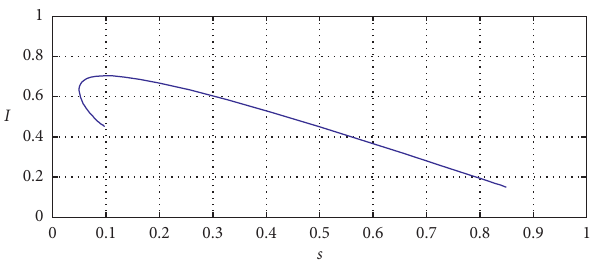
Figure 4: Phase trajectory diagram.